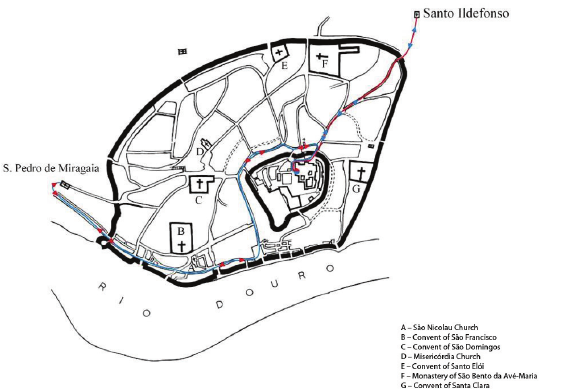
Figure 6: The procession of “Corpus” Christy before 1559